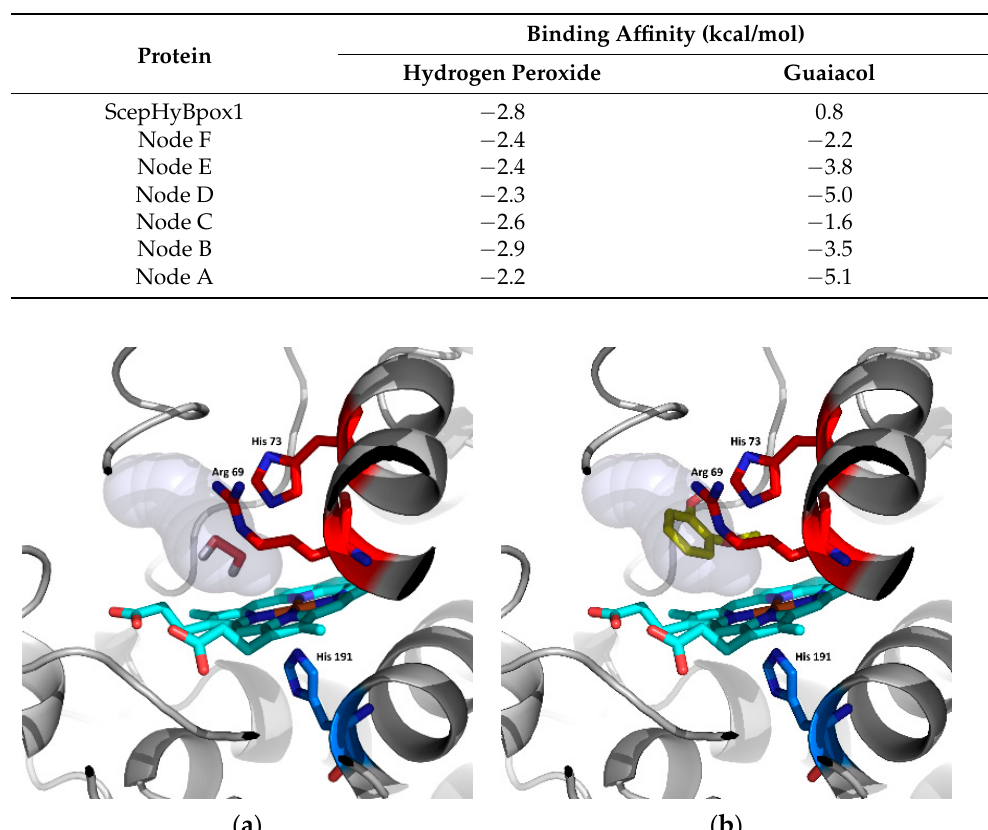
Figure 7. Structural presentation of a 3D model of the active centre in ScepHyBpox1 reconstructed with AlphaFold 2 [25]. Models of active centres for six ancestors from nodes A–F (cf. Figure 3) are also superimposed. Colour scheme: cyan—prosthetic heme group, red—residues involved in the catalytic machinery on the distal side, blue—proximal histidine. Table 2. Potential substrate binding in active centres of all modelled heme peroxidases, calculated using Autodock Vina software [28].